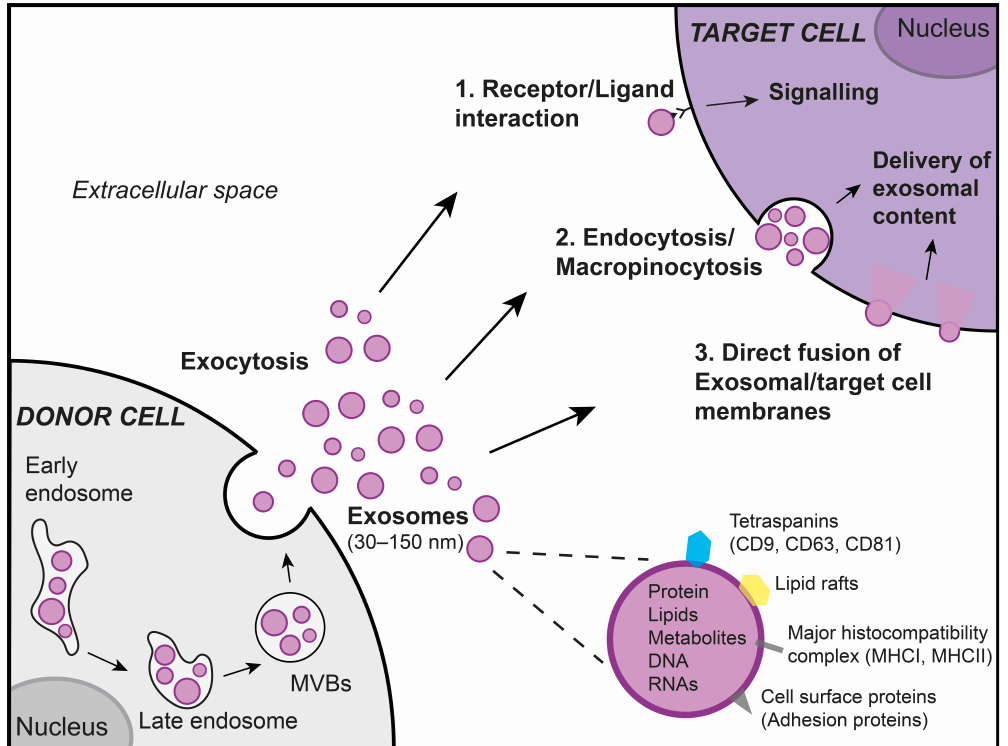
Figure 1. Exosomes in intercellular communication. Exosomes are nanovesicles (30–150 nm), which originate from the endosomal pathway by the formation of the early endosomes, late endosomes, and, ultimately, multivesicular bodies (MVBs). These vesicles are released to the extracellular microenvironment through MVB fusion to the plasma membrane and exocytosis. Exosomes contain many components of donor cells, including cell-surface proteins, lipids, metabolites, and genetic material, which confer them functional properties. Exosomes can transfer information to the target cell by (1) interacting with the cell surface, via a receptor-mediated mechanism, or by delivering its content to the target cell through (2) endocytosis, macropinocytosis or (3) through a direct fusion of exosomal membrane with the plasma